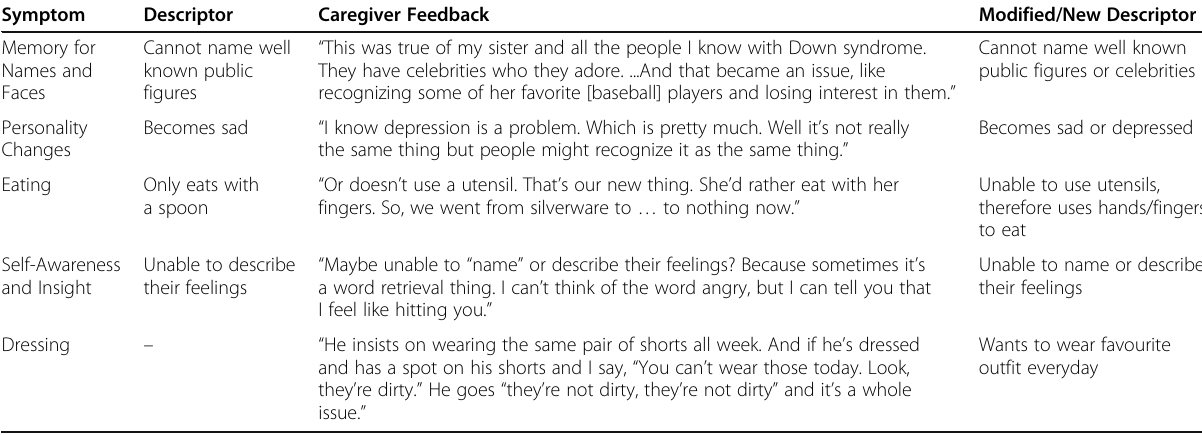
Table 3 Examples of menu revisions based on caregiver